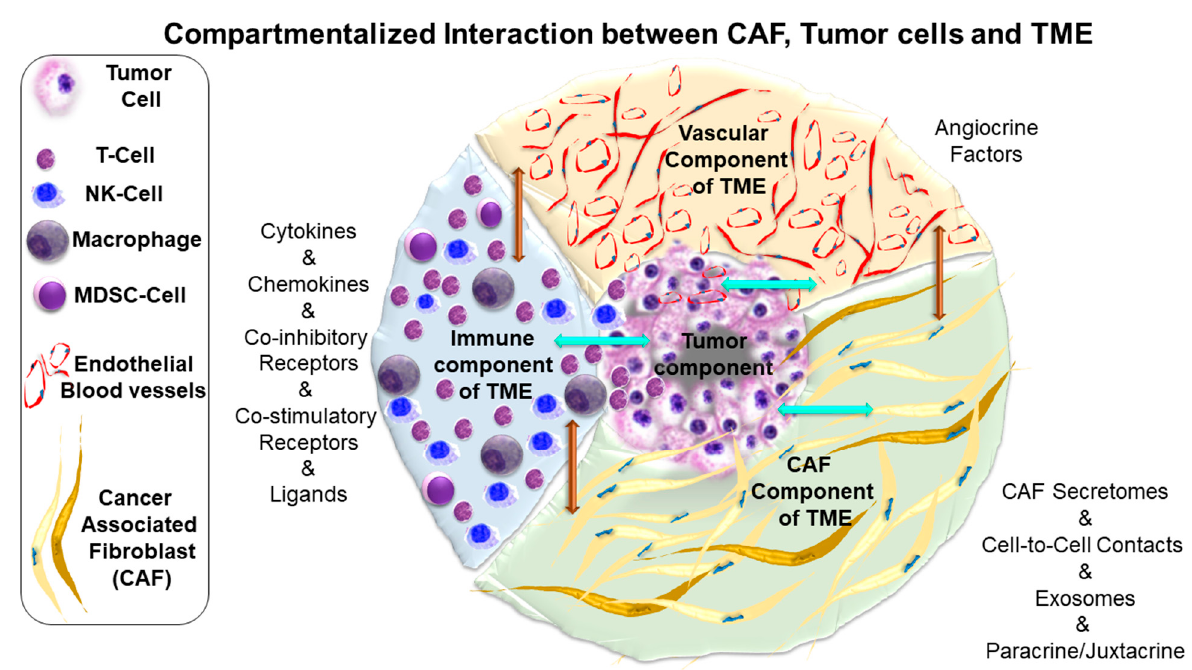
Figure 1. Diagrammatic representation of the compartmentalized relationship of cancer-associated fibroblasts (CAF) with tumor cells and other components of the tumor microenvironment (TME): CAF interacts and has a bidirectional influence on other two major components of TME, including the immune component and vascular component (vertical brown arrows). All three components of TME interact (vertical brown arrows) and have bidirectional interaction with the tumor compartment (horizontal cyan arrows). The bidirectional interactions are not compartmentalized in space as all the components are in close proximity for autocrine/paracrine interactions but compartmentalized on a cell-to-cell basis. CAFs have distinctly compartmentalized bidirectional interactions with cells of the immune component and vascular component of TME, which are distinct from the bidirectional interactions with tumor cells. These characteristic interactions are (1) via secretomes, (2) autocrine, paracrine, and angiocrine in nature, and/or (3) cell-to-cell interactions. Interestingly, the bidirectional interactions are also in real-time. For example, CAF's interaction with other components of TME and tumor cells changes following treatment of the tumor with drug(s), which may be functionally connected to the development of resistance. Schematically, each component of TME is compartmentalized, and a few cells of each component are presented within the tumor compartment. Heterogeneity of CAF is represented in two shades of color.